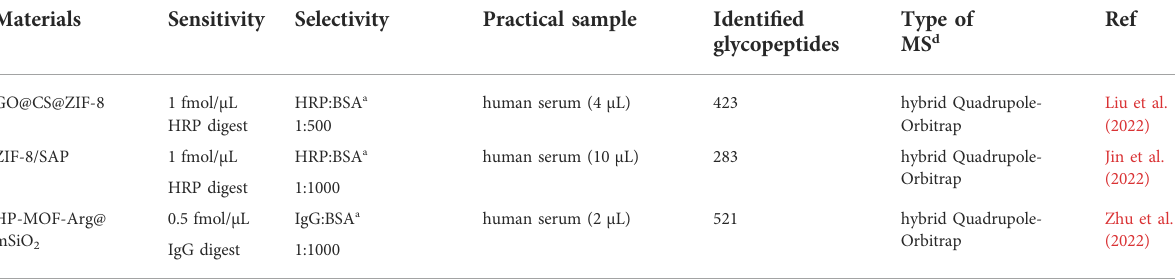
a Mass ratio of enzymatic hydrolysate. b Molar ratio of enzymatic hydrolysate. c Mass ratio of enzymatic hydrolysate and protein; - not mentioned. d LC-MS,havebeenusedtoidentifyglycopeptidesinpracticalsample.ThetypesofMS,arelistedinthetable.IntheTable,MALDI,istheabbreviationofMatrix-AssistedLaserDesorption Ionization; TOF, is the abbreviation of Time of